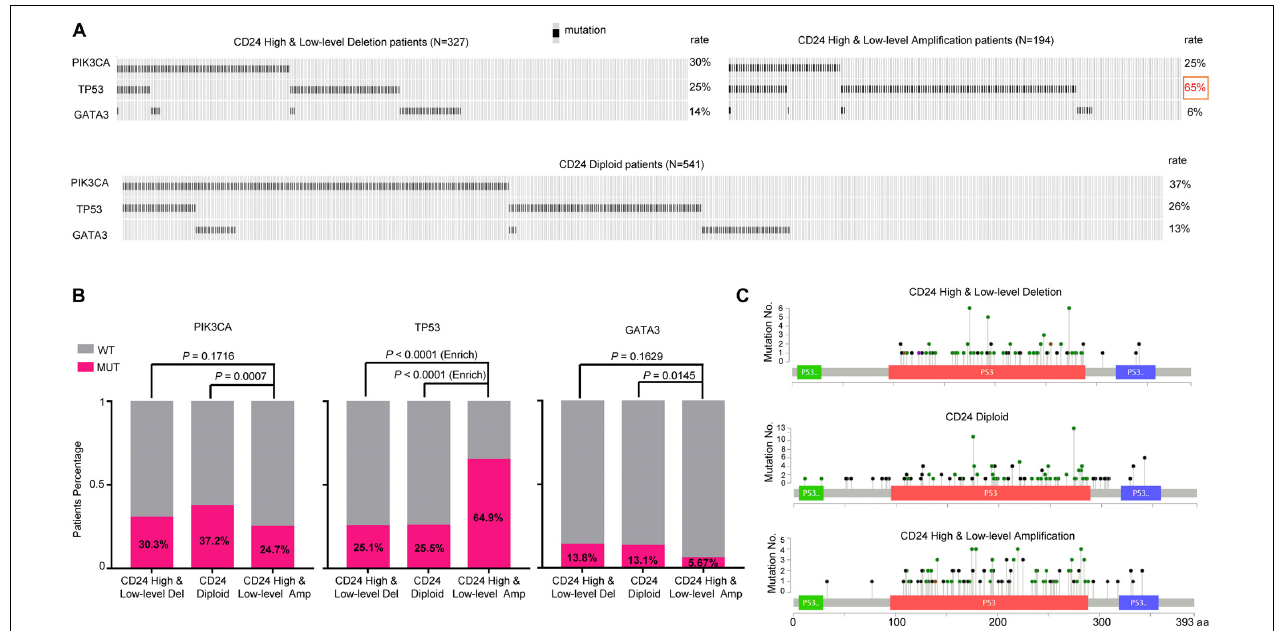
FIGURE 4 | TP53 mutation is selectively enriched in CD24 amplification samples. (A) cBioPortal OncoPrint plot showing the distribution of PIK3CA , TP53 and GATA3 mutation rate in the TCGA BRCA dataset. (B) Bar graphs showing the percentage of TCGA BRCA samples with mutations in PIK3CA, TP53 , and GATA3 by different CD24 copy number groups. (C) cBioPortal Lollipop plot showing the loci distribution of mutations in TP53 across TCGA BRCA samples.